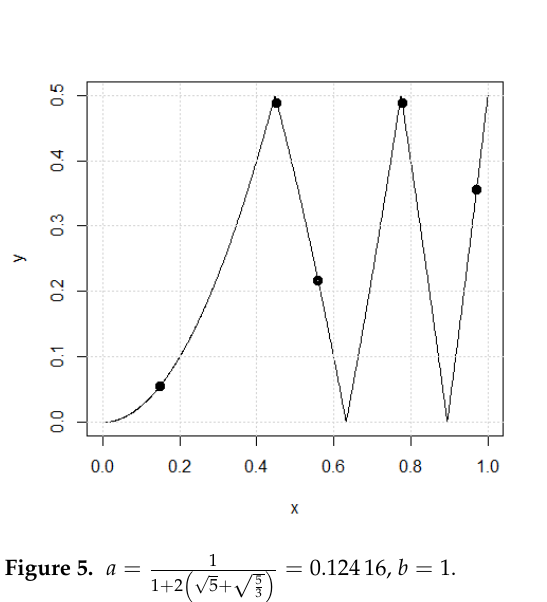
√ Figure 5. a = 1 (cid:16) √ (cid:17) = 0.12416, b = 1. 5 1 + 2 5 + 3 The second case: the same